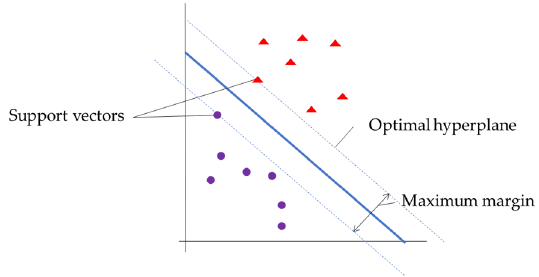
Figure 1. Base of support vector machines.